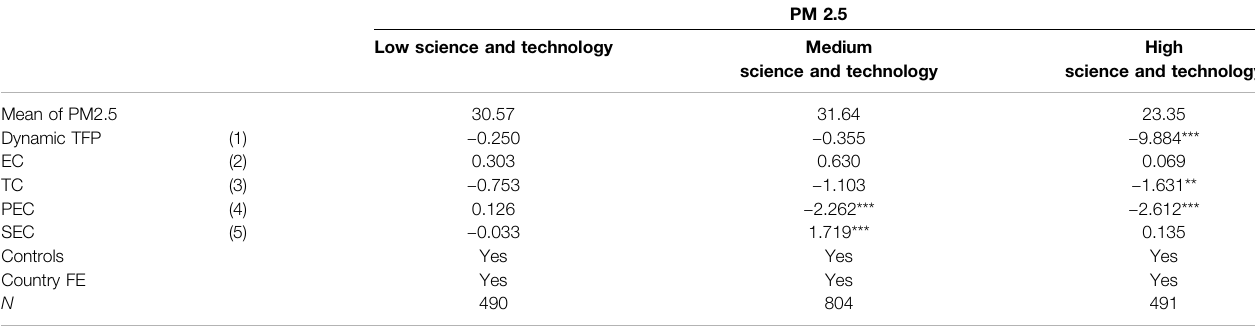
TABLE 9 | The estimation results for science and technology level